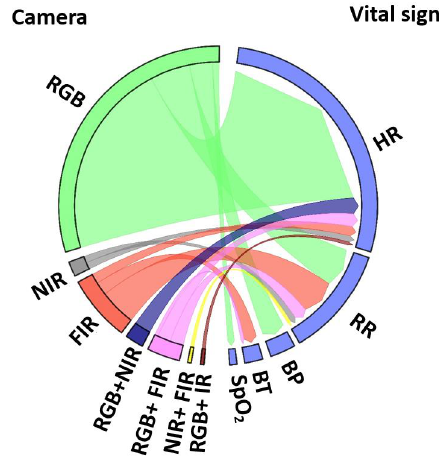
Figure 6. Chord diagram of conceptual semantics between camera and vital sign.